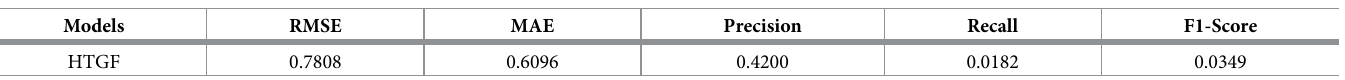
Table 14. Cluster 2 results.